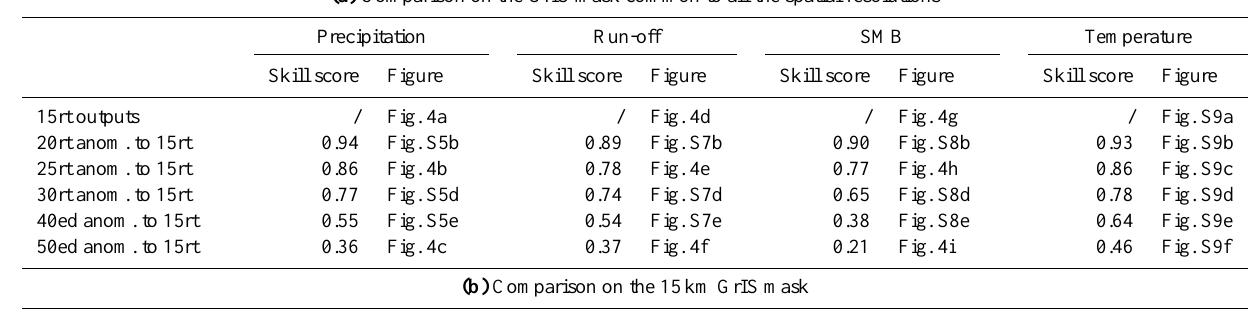
15rt outputs 25rt anom. to 15rt Corr. 25rt anom. to 15rt